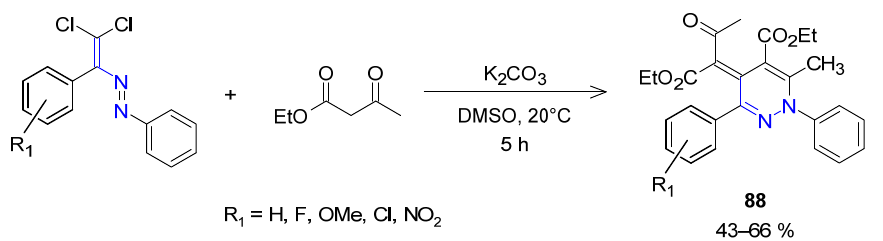
diazabuta-1,3-dienes, with malonate ester or cyanoacetic esters.